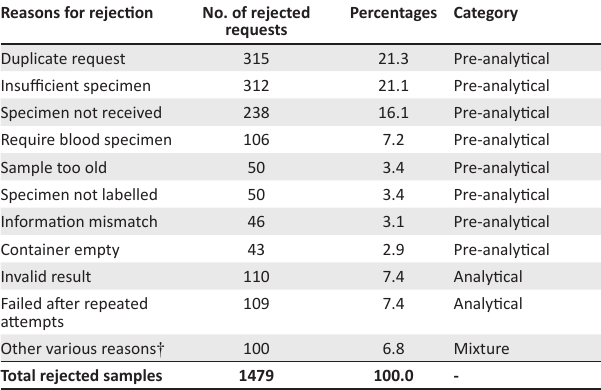
TABLE 1: Reasons for rejection of HIV polymerase chain reaction test requests at Tygerberg Hospital, Cape Town, South Africa, between July 2017 and June 2019.